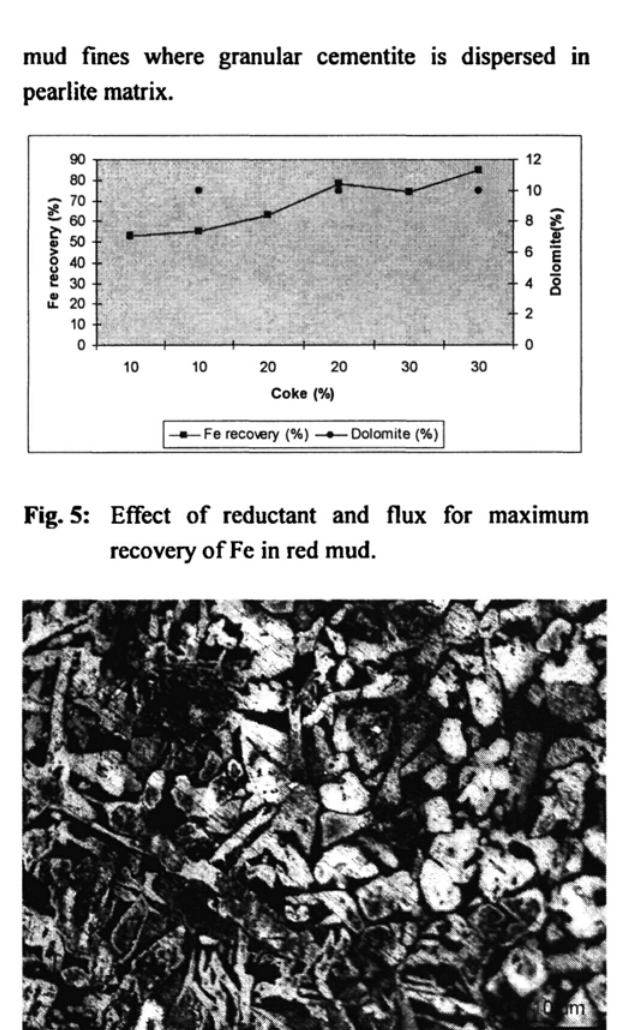
Microstructure of pig iron from red mud -100X